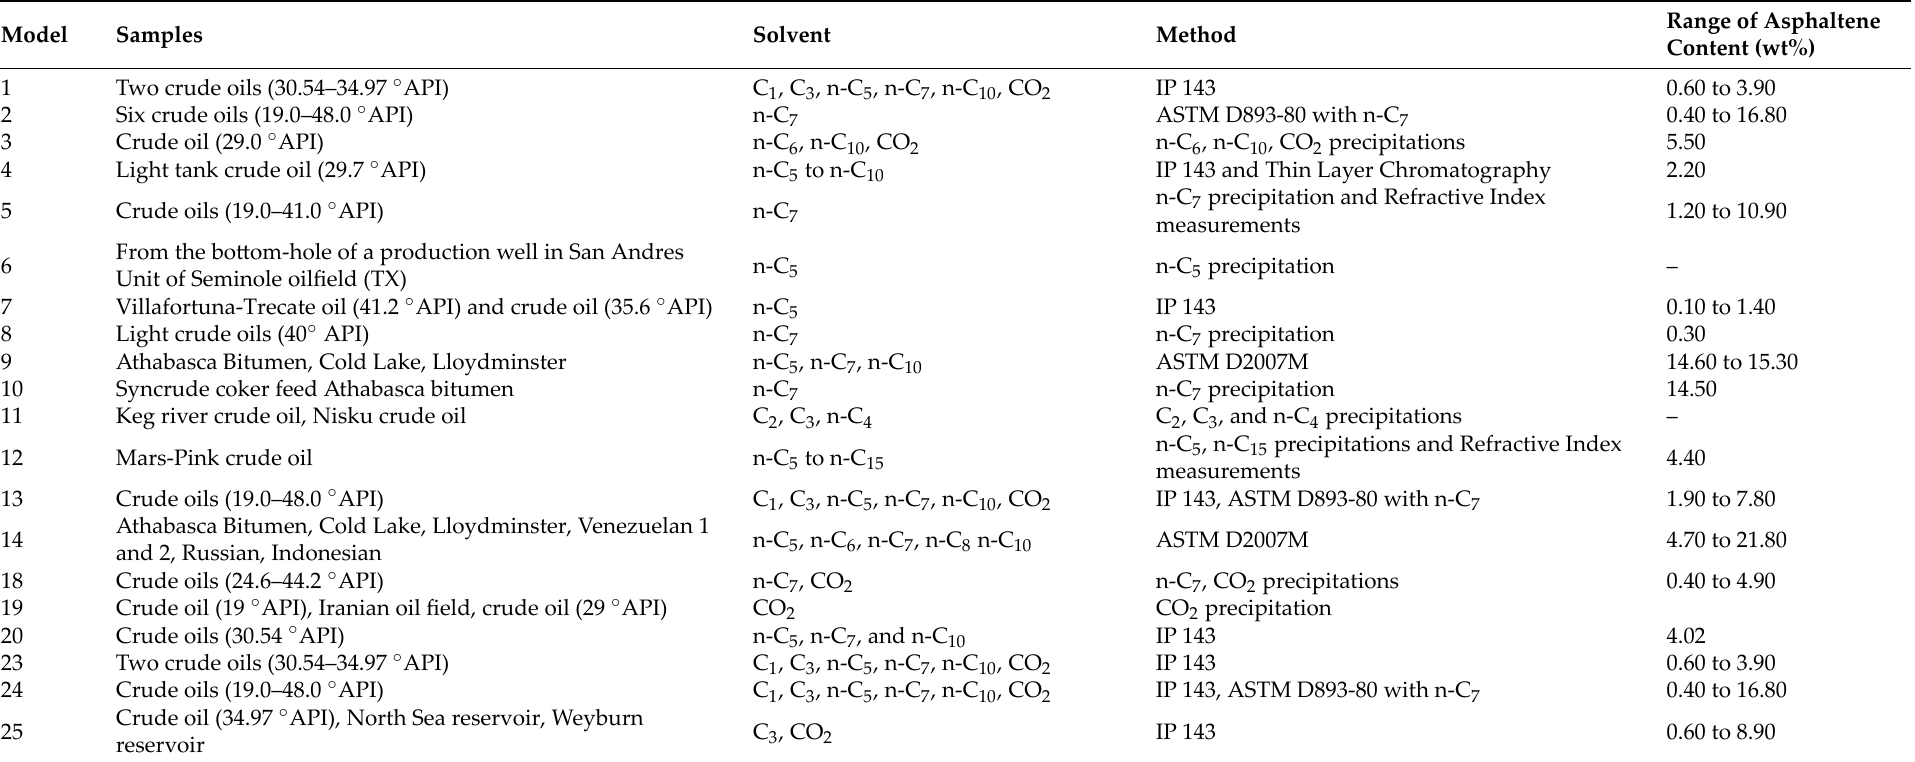
Table 5. Samples, solvents, and methods for experimental titrations for asphaltene